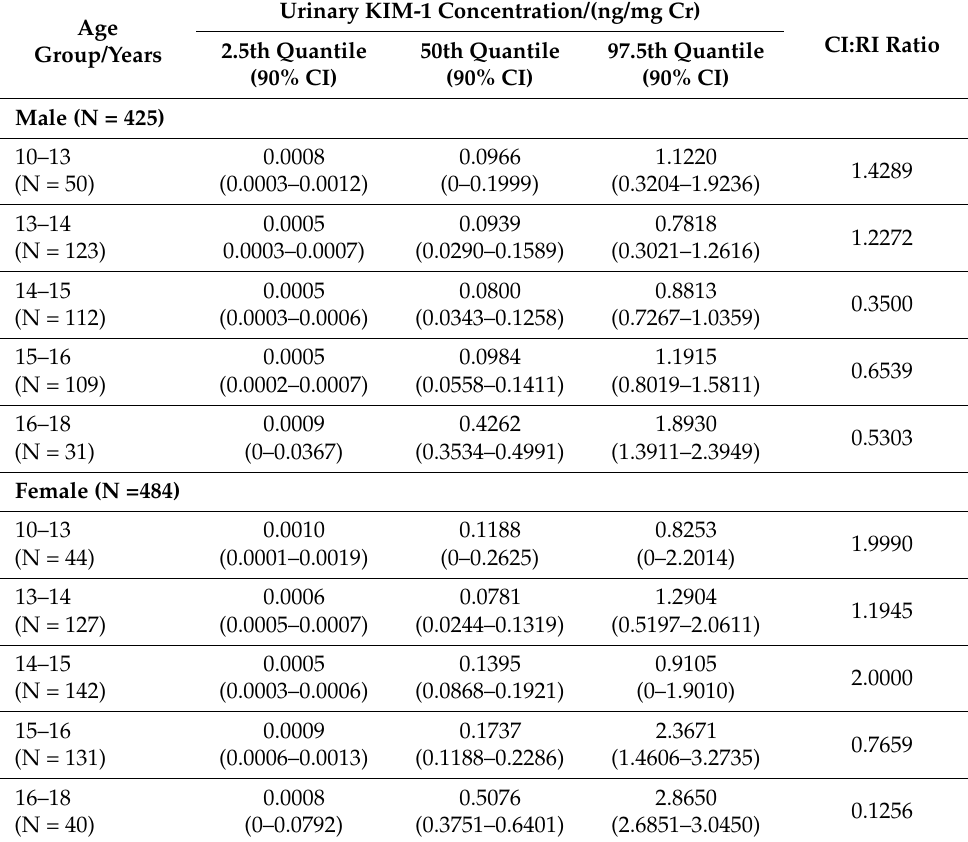
Table 1. The reference intervals (RI) and confidence intervals (CI) for the creatinine-adjusted urinary KIM-1 levels for children. The ratio of the 90% confidence interval to the reference interval of the 97.5th quantile is given as the CI:RI